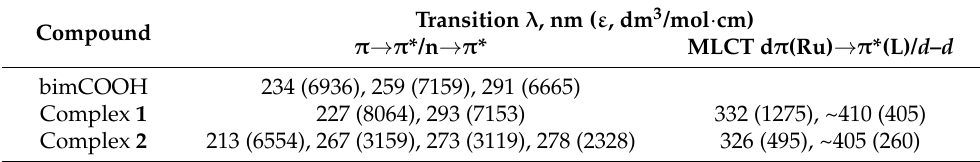
Table 1. UV–vis spectroscopic data for the ligand and the arene ruthenium(II) complexes.